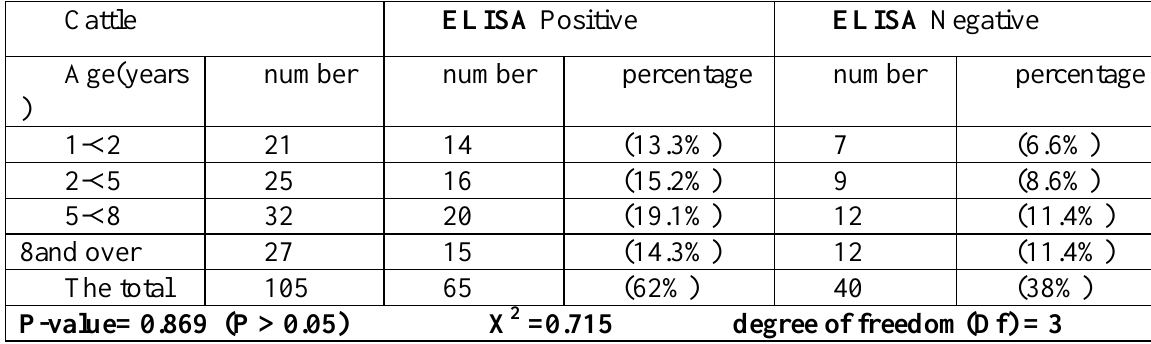
Table(1): The result of ELISA according to the age group of cattle Cattle